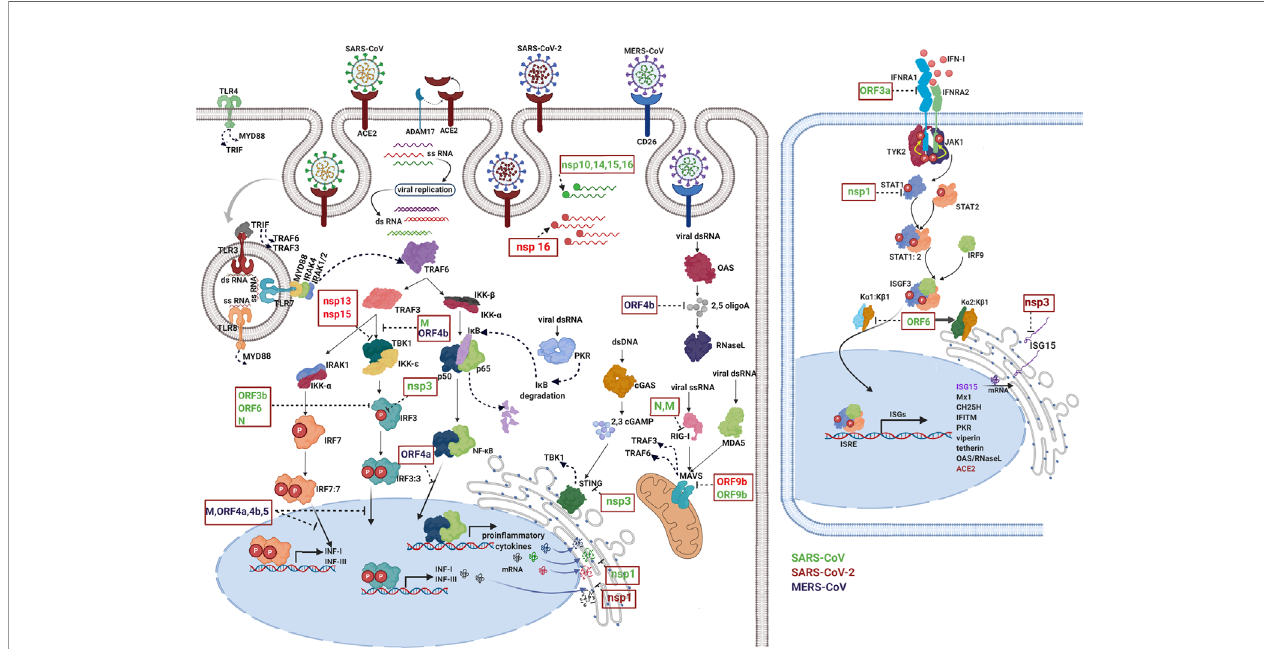
FIGURE 3 | Immune evasion by coronaviruses. The image schematically represents how viral proteins of Betacoronavirus (green: SARS-CoV, red: SARS-CoV-2, and purple MERS-CoV) are capable of inhibit different events of the immune response such as pathogen detection, IFN production, IFN signaling, and ISG functions. Each viral protein blocks one or more key signaling proteins. First, viruses modify their nucleic acids to avoid being recognized by cytosolic receptors. Viral RNA can be guanosine-capped and methylated at the 5 ’ end by SARS-CoV nonstructural proteins (nsp 10, nsp14, nsp15, and nsp16), allowing the virus to ef fi ciently evade recognition of host dsRNA sensors (57 – 62). Viral proteins inactivate key intermediates in the recognition of pathogens, for example, RIG-I activation is blocked by SARS-CoV N protein (63) and M protein the latter is physically associated with RIG-I (64). Additionally, other viral proteins inhibit different intermediate steps in the signaling cascade for the production of IFN, for example: ORF9b from SARS-CoV-2 and SARS-CoV indirectly interact with MAVS in mitochondria (65, 66). Signaling through STING in the endoplasmic reticulum is antagonized by SARS-CoV nsp3 (67). Viral proteins interfere with complex formation such as TBK-1, which is inhibited by SARS-CoV M and MERS-CoV ORF4b (64, 68). Also, SARS-CoV-2 nsp13 and nsp15 interfere with TBK-1 signaling and IRF3 activation (66). Phosphorylation reactions and translocation to the nucleus of key proteins in the signaling cascade are also targeted by viral proteins, for example, SARS-CoV nsp3, N, ORF3b and ORF6 (69, 70). Viral proteins are even capable of inhibiting the function of transcriptional factors speci fi c for the induction of INFs and proin fl ammatory cytokines. Proteins of MERS such as ORF 4a, ORF 4b, ORF 5, and M inhibit IRF-3/IRF-7 function and ORF 4a inhibits NF- k B function (68). Additionally, nsp1 protein of SARS-CoV and SARS-CoV-2 suppresses host gene expression by promoting mRNA degradation leading to a strong protein synthesis inhibition, including proteins involved in host innate immune functions (71, 72). The right panel shows how several viral proteins block IFN signaling, SARS-CoV ORF3a protein induces degradation of IFN alpha-receptor subunit 1 (IFNAR1) (73). SARS-CoV nsp1 signi fi cantly inhibited IFN-dependent signaling by decreasing the phosphorylation levels of STAT1 (74). Additionally, SARS-CoV ORF6 protein inhibits nuclear translocation but not phosphorylation of STAT1, this occurs through the recruitment of karyopherin ( a 2 and b 1) in the endoplasmic reticulum, thus preventing the translocation of the ISGF-3 complex to the nucleus (75). Finally, coronaviruses inhibit the effector function of ISGs, for example, MERS-COV ORF4b antagonizes activation of the OAS-RNase L pathway through its 2,5 – phosphodiesterase activity that degrades the products of OAS (2,5 oligoA) which prevent activation of RNase L (76). Nsp3 encoded by SARS-CoV-2 is responsible for the suppression of host innate immune responses through the reversal post-translational modi fi cation of proteins performed by ISG15 (50). For further details visit